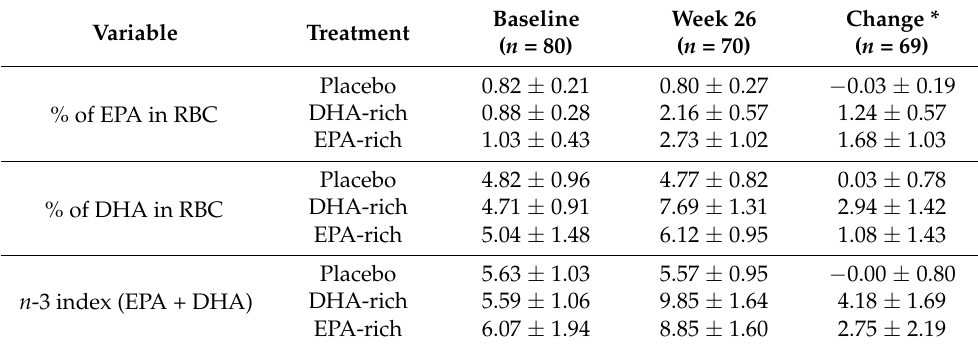
Table 3. Red blood cell EPA, DHA, and n -3 index for placebo, DHA-rich, and EPA-rich treatment groups. Data are mean ± SD at baseline, week 26, and change (from baseline).